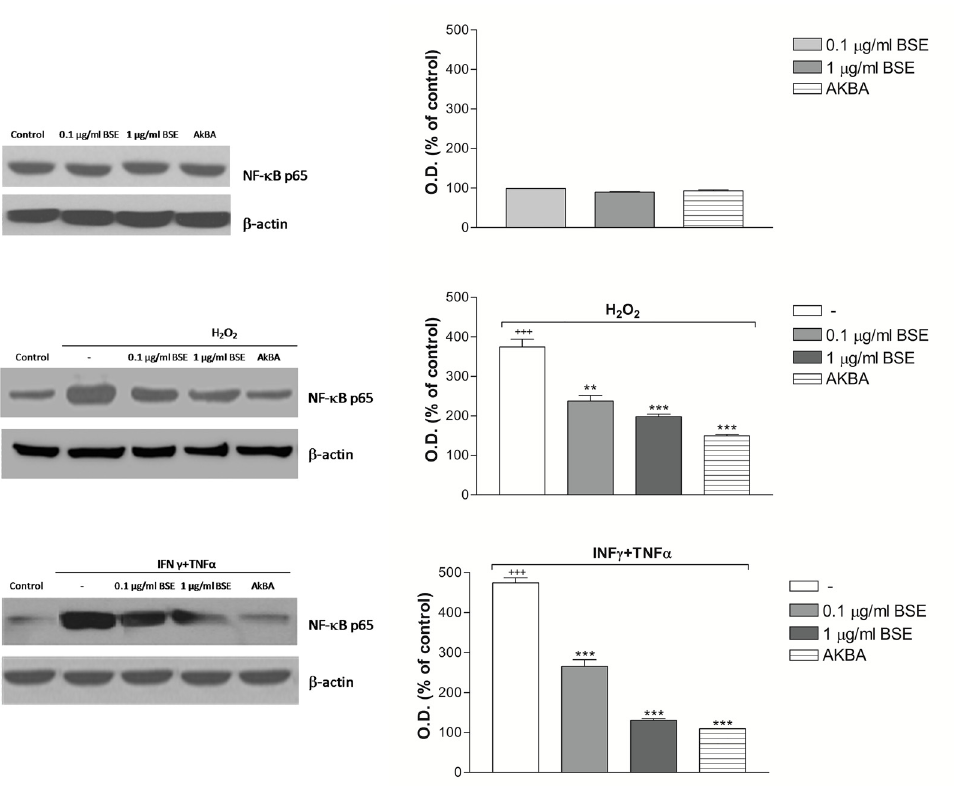
Fig 7. BSE and AKBA effect on NF-kB intracellular level in Caco-2 cells. A) basal condition; B) BSE and AKBA + 4 hours with H 2 O 2 +++ p < 0.001 H 2 O 2 vs control. *** p < 0.001 BSE and AKBA vs H 2 O 2 ** p < 0.01 BSE and AKBA vs H 2 O 2 . C) 24 hours pretreatment with BSE and AKBA + 4h with INF- γ +TNF- α as described in method. +++ p < 0.001 INF γ +TNF α vs control + p < 0.05 INF γ +TNF α vs control *** p < 0.001 BSE and AKBA vs INF- γ +TNF- α . Data are shown as mean ± SEM percentage of control optical density (OD) of n = 3 experiments.